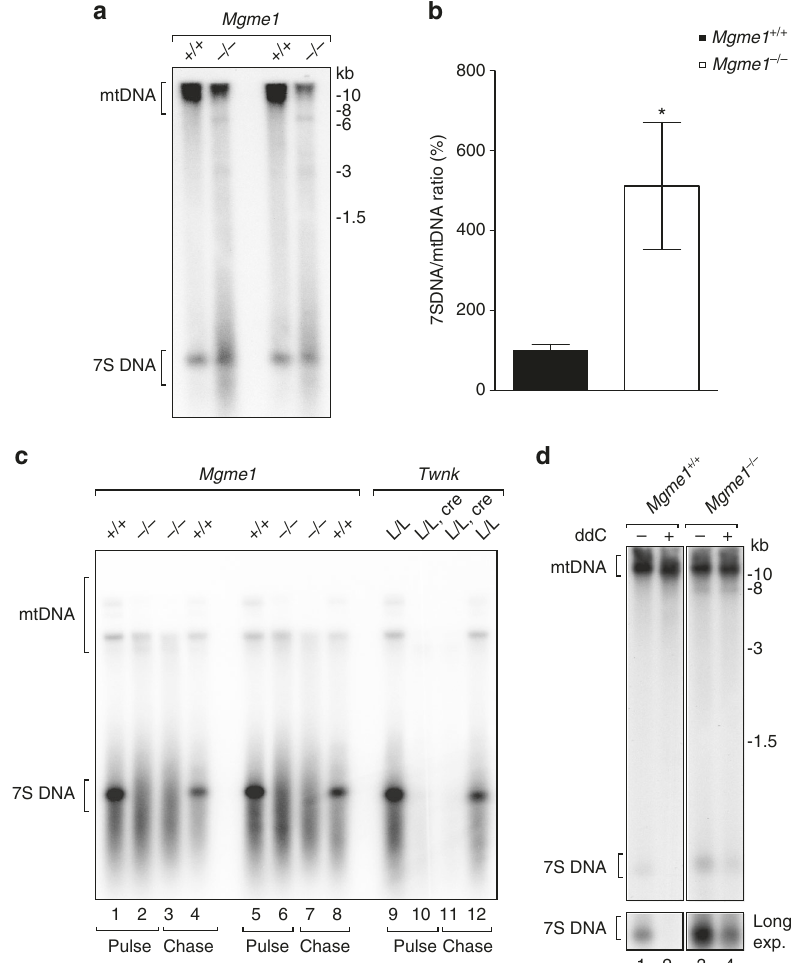
Fig. 5 Increased 7S DNA stability and diminished 7S de novo synthesis in Mgme1 knockout mice. a Southern blot analysis of SphI-digested mtDNA in heart from wild-type ( + / + ) and Mgme1 knockout mice ( − / − ). b Southern blot quanti fi cation: ratio of 7S DNA to mtDNA signal. Error bars represent the SEM. * P < 0,05; Student ’ s t -test. n = 4 biological replicates per genotype. c De novo DNA synthesis in heart mitochondria isolated from 8-week-old control ( Mgme1 + / + ) and Mgme1 knockout ( Mgme1 − / − ) mice and Twnk control ( Twnk L/L ) and tissue-speci fi c knockout ( Twnk L/L , cre) heart mitochondria. Mitochondria were pulse labeled for 2 h and the chase was performed for 1 h. d Southern blot analysis of SphI-digested mtDNA and 7SDNA from 3 days ddC treated ( + ) or untreated ( − ) mouse embryonic fi (Fig. 5d, lane 4 vs lane 2). To elucidate whether the increased stability of 7S DNA was associated with structural changes, we de fi ned the 3 ′ and 5 ′ ends of 7S DNA in Mgme1 − / − mice (Supplementary Fig. 5a, b). Ligation-mediated (LM)-PCR analysis showed a tendency of shift towards longer 5 ′ DNA ends in the absence of MGME1 (Supplementary Fig. 5a, b). In contrast, LM- PCR analyses as well as 3 ′ polyadenylation-mediated PCR ampli fi cation revealed only modest changes in the 3 ′ ends of 7S DNA of Mgme1 − / − mice (Supplementary Fig. 5a). Extended 5 ′ ends of 7S DNA have also been reported in fi broblasts from patients with MGME1 mutations and it has been speculated that this may explain the increased stability of 7S DNA 23 .